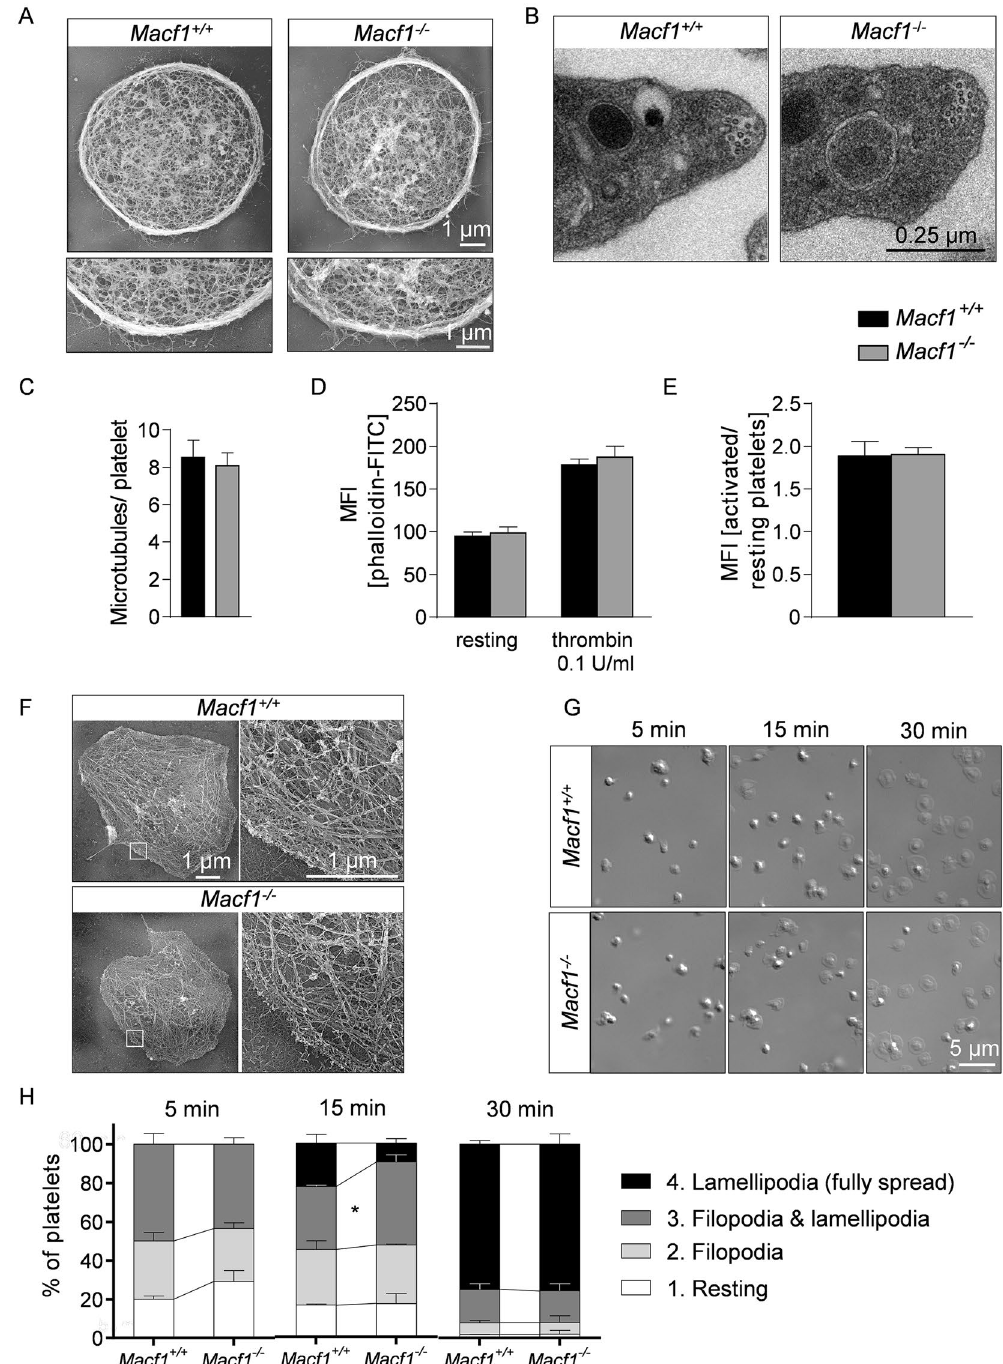
Figure 3. Lack of MACF1 does not affect microtubule and actin arrangement. (A) Images of the platelet cytoskeleton ultrastructure on poly-L-lysine (n = 2). (B) TEM images of resting platelets (n = 4) and (C) evaluation of microtubule number. (D) Resting or thrombin-activated platelets were fixed, permeabilized, stained with phalloidin-FITC, and analyzed by flow cytometry. (E) The ratio of polymerized actin in activated vs. resting platelets was determined (n = 3, representative for two independent experiments). (F) Representative transmission electron micrographs of the cytoskeleton ultrastructure of platelets spread on fibrinogen in the presence of 0.01 U/ml thrombin (n = 2). (G) Representative images and (H) statistical analysis of the different spreading phases of fixed Macf1 + / + and Macf1 − / − platelets on fibrinogen at different time points (n = 3). * P <